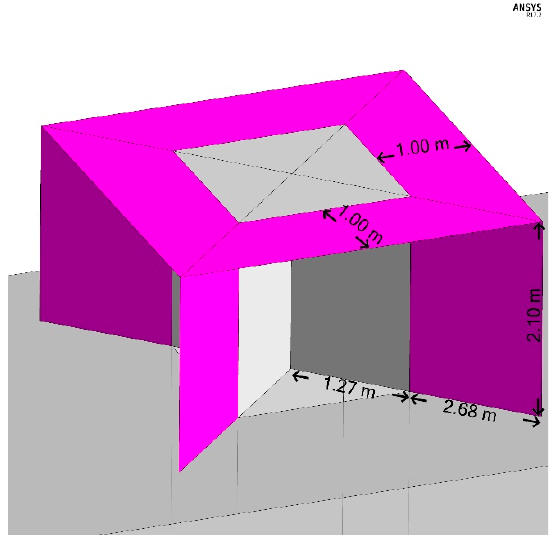
Figure 12. Wind catcher ‘empty + 1 m’ – dimensions of the enlarged sidewalls (deflectors) of the wind catcher version ‘empty’.